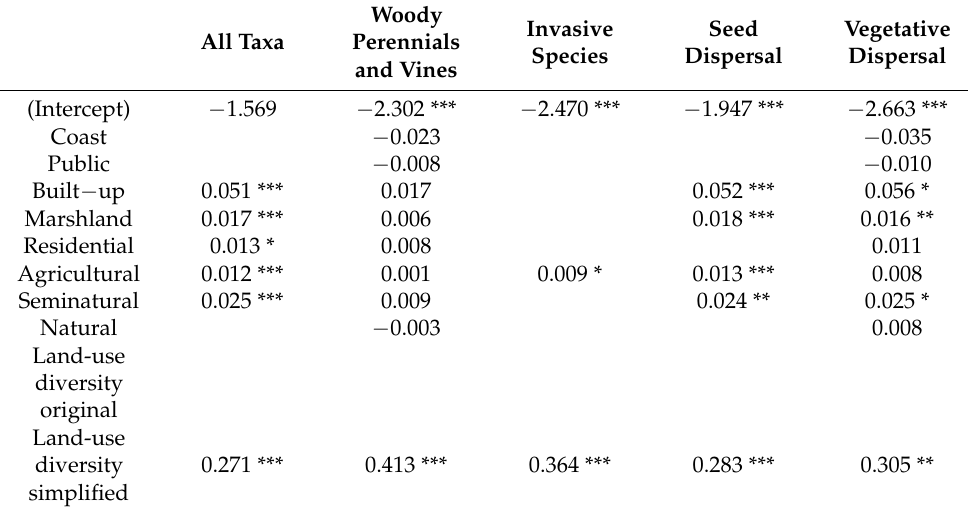
Table 4. Richness (count data) of all taxa, woody perennials and vines, annual herbs, invasive species, and taxa considered based on predominant seed or vegetative dispersal explained by simplified categories of land-use and land-use diversity. Coefficients of generalized linear models (Poisson distribution) selected according to the lowest AIC value. Statistically significant values are